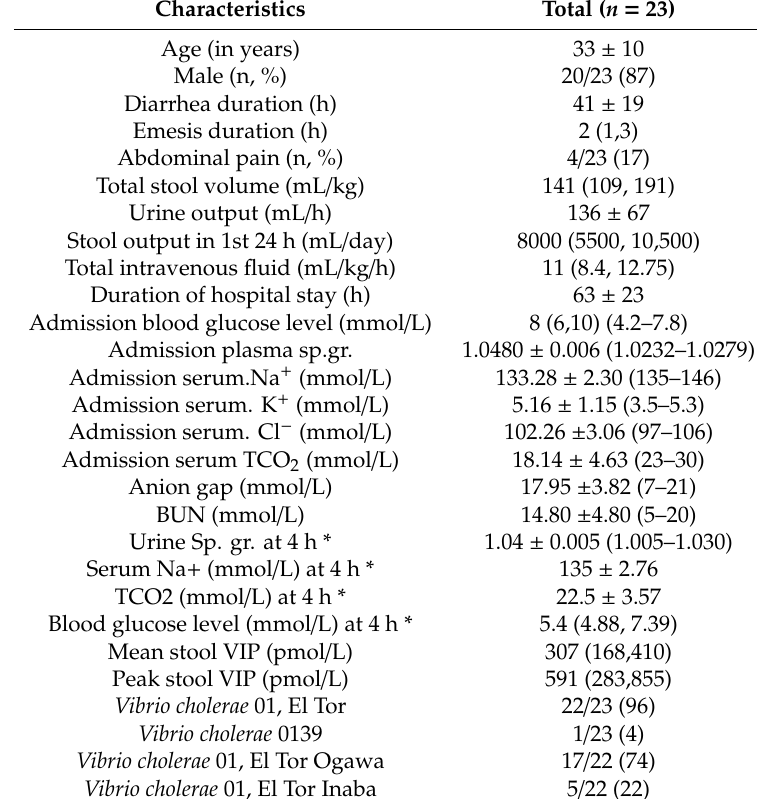
Table 1. Clinical and laboratory characteristics of cholera patients with severe dehydration / hypovolemic shock in Dhaka, Bangladesh.